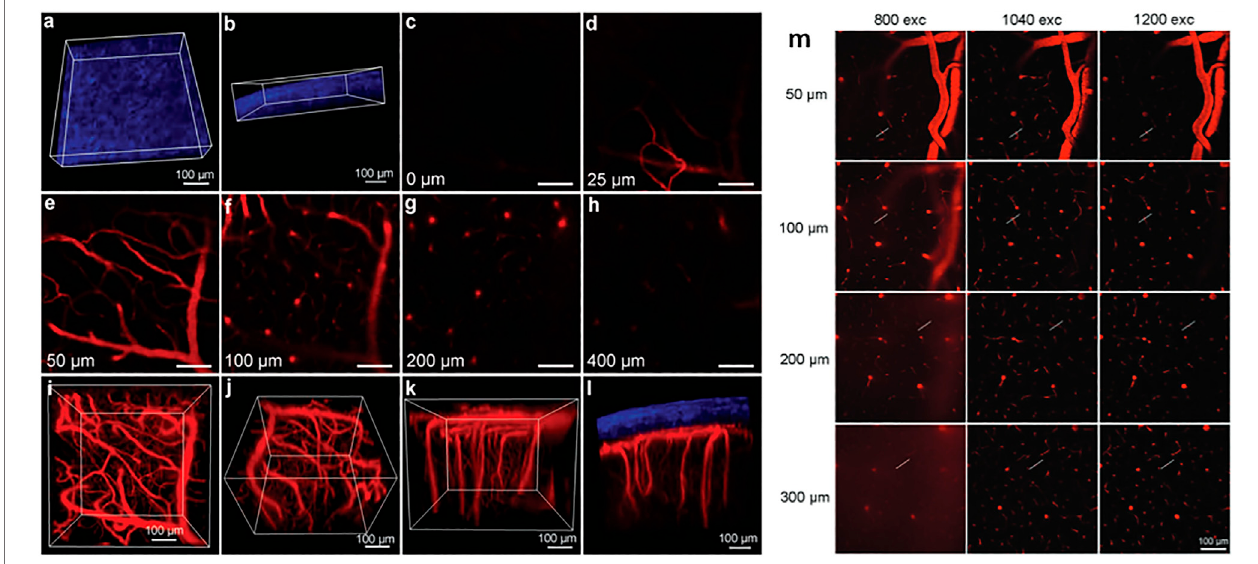
FIGURE8| 2PAimagesofbrainbloodvesselsinamouseinjectedwithCPdots. (a,b) 3Dreconstructedsecond-harmonicgenerationimagesofmouseskull. (c – h) 2PA images at various vertical depths (0 – 400 μ m) at 1200 nm excitation, 660 – 750 nm emission. (i – l) 3D reconstructed 2PA images of brain blood vessels. (m) comparison of 2PA images at excitation wavelengths of 800, 1040, and 1200 nm, of brain vasculature in a mouse injected with polymer dots. 2PA line intensity pro fi les withthedifferentwavelengthsacrosstheblood vessels onthe rightwerealso acquired for thecorresponding depths.Emission at 660 – 750 nm.Reprinted from ref (Wang et al., 2019b). with permission from John Wiley and